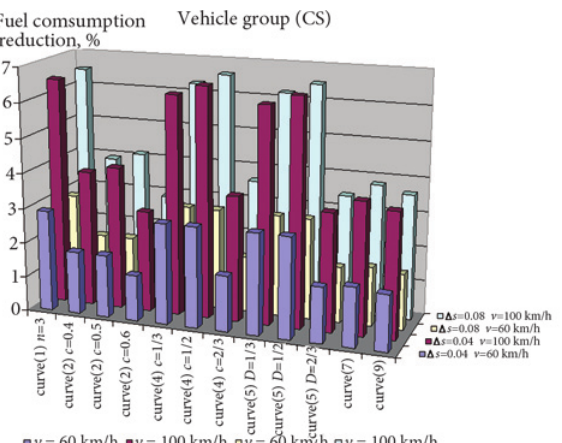
Fig. 9. Fuel consumption reduction in variant B, %, in vehicle group (CN)